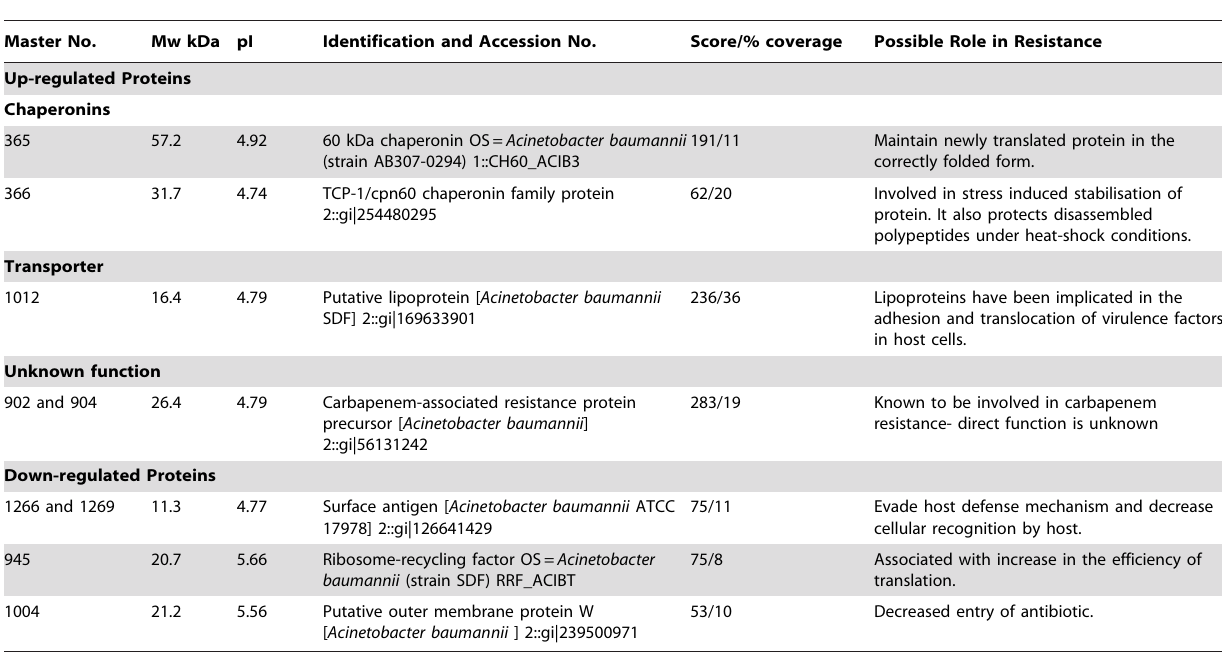
Table 3. Identification of differentially expressed proteins of inner membrane fraction of Acinetobacter baumannii resistant strain, RS307 with reference to ATCC 19606.